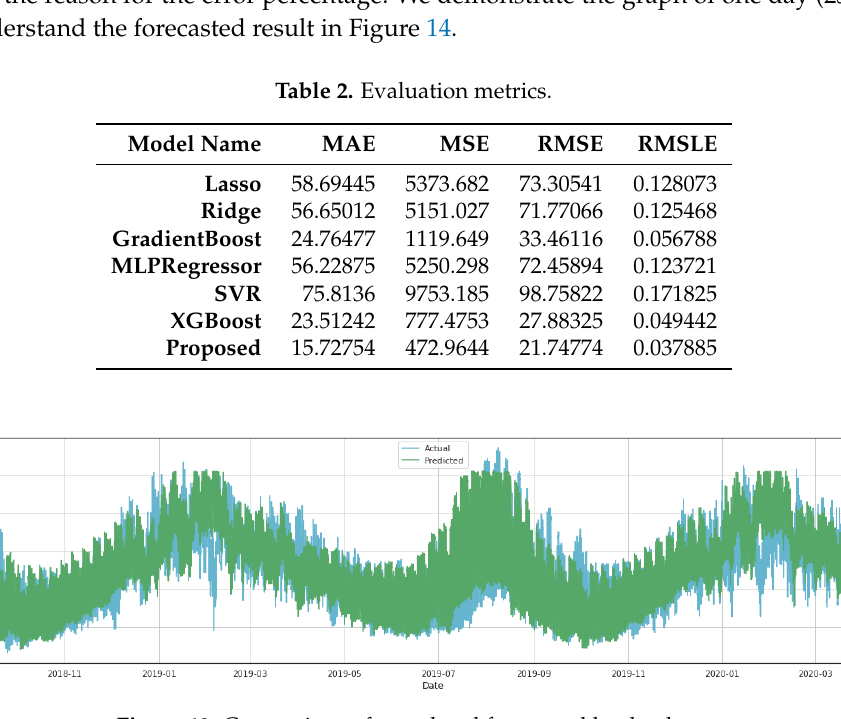
Figure 12. Comparison of actual and forecasted load values.